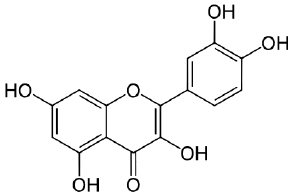
Figure 1. Chemical structure of